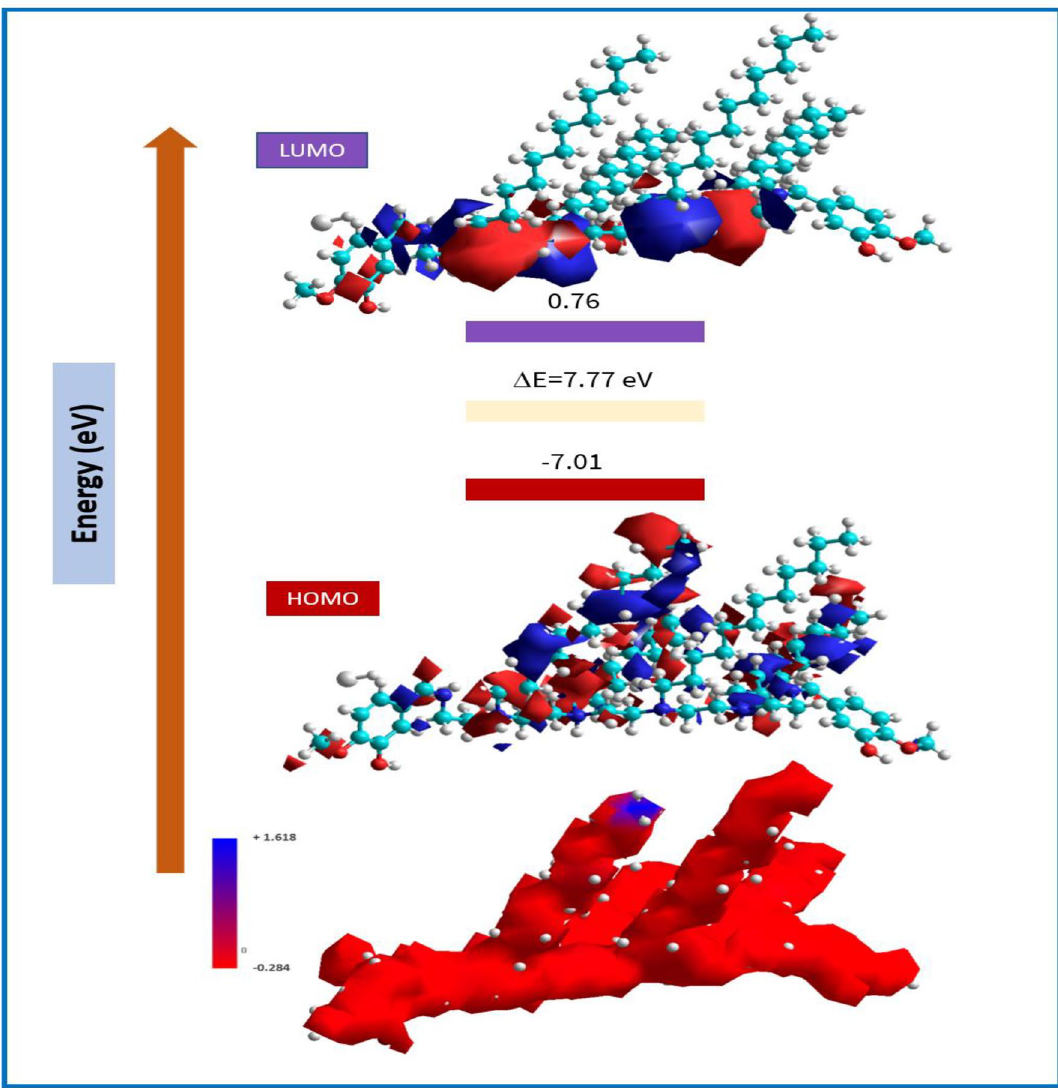
Figure 10. HOMO and LUMO surfaces as well as the electrostatic potential (ESP) for CS4